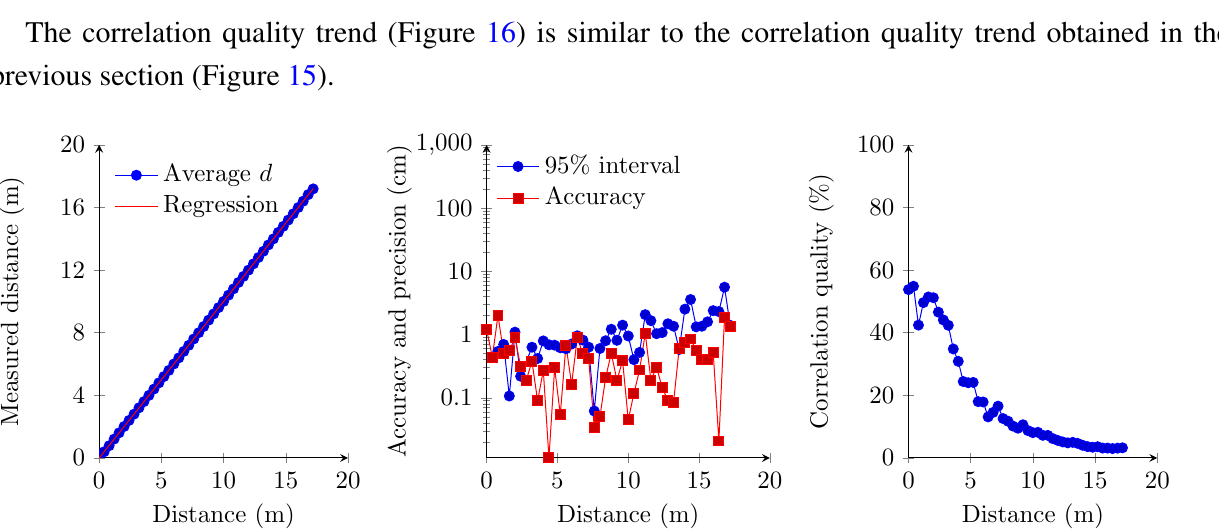
Figure 16. Linear regression of the measured distances ( left ); accuracy and the 95% confidence interval ( middle ); and correlation quality ( right ). In these measurements, the amplitude of the transmitter is 12 V in a single access